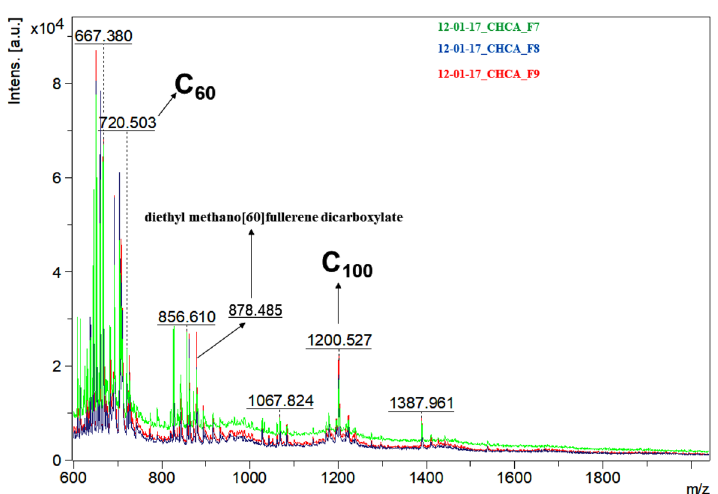
Figure 2. MALDI-MS profile of one fine aerosol sample analyzed in triplicate. Typical spectra of the sample presenting high repeatability between three replicates using the CHCA